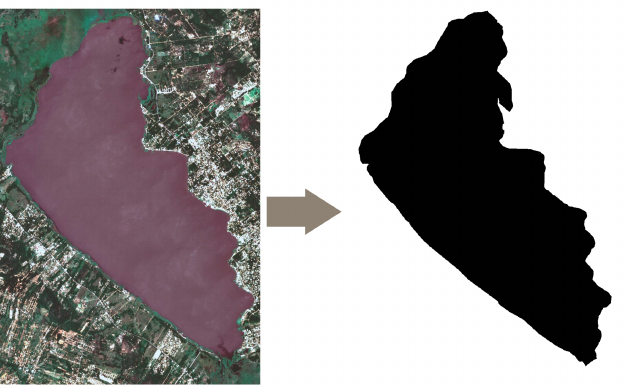
Figure 2. Image representation of the Ypacarai Lake model. Note that, since there exist segments represented with two black squares that cross white squares (obstacles or terrain), X is a non- convex